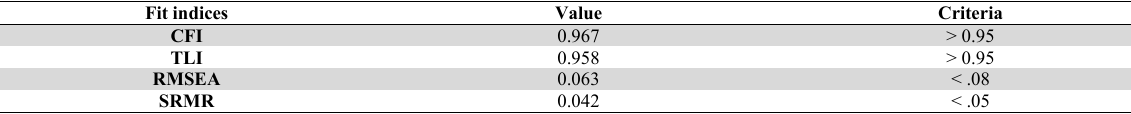
Goodness-of-fit of the structural